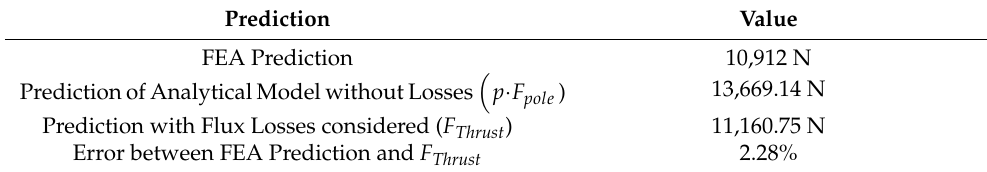
Table 4. Results